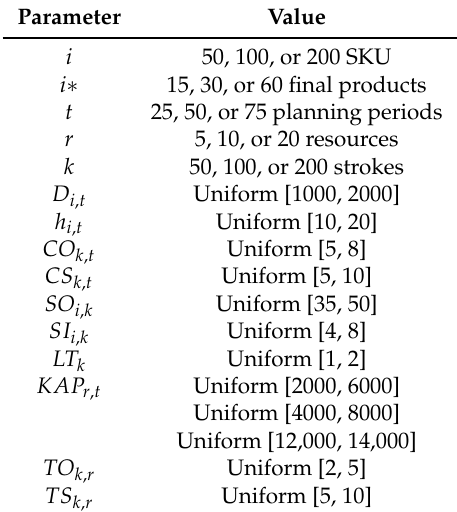
Table 4. Parameter settings for randomly-generated test cases [28].